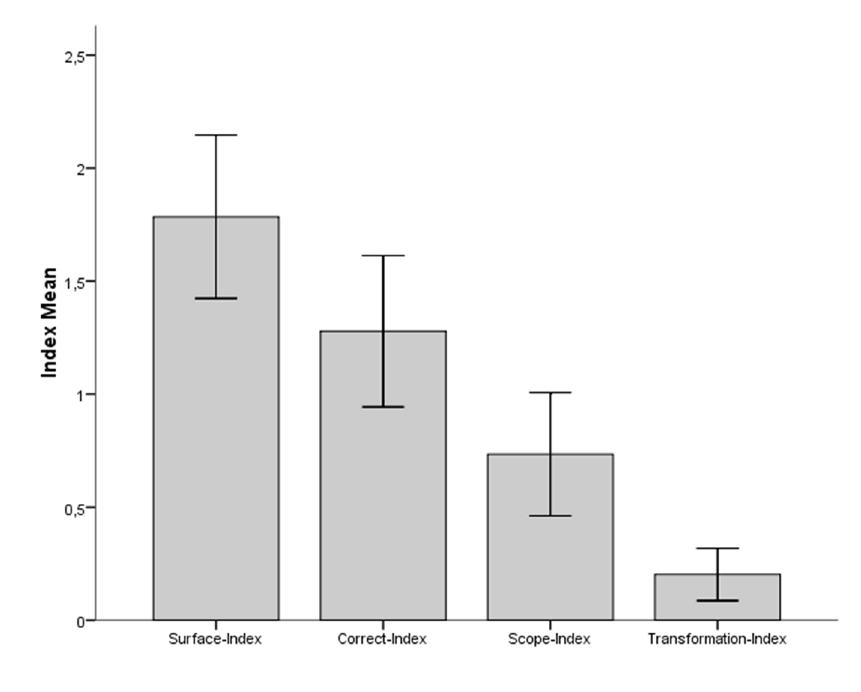
Figure 2. General response pattern for law 2. Error bars represent a 95% confidence interval for the mean.